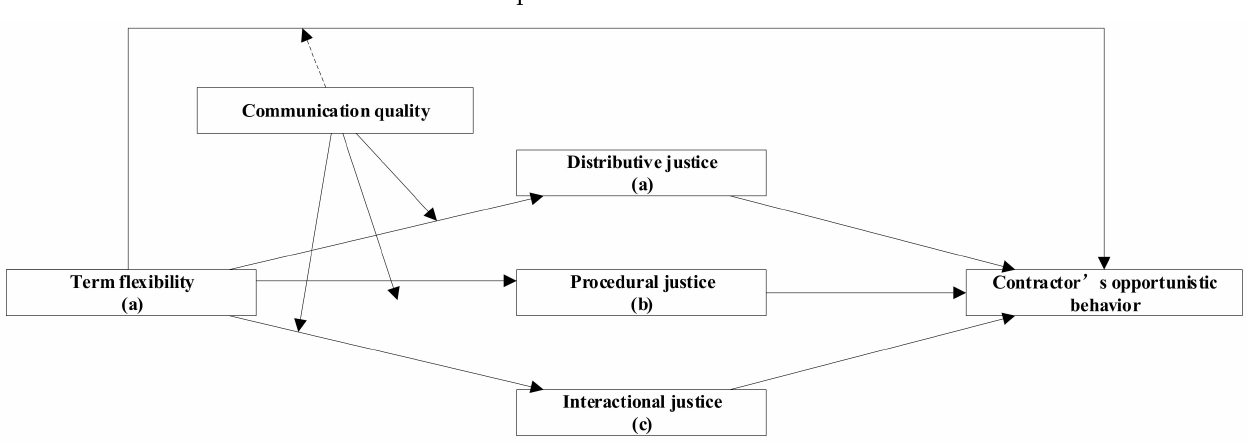
Figure 3. Diagram A of the model results.